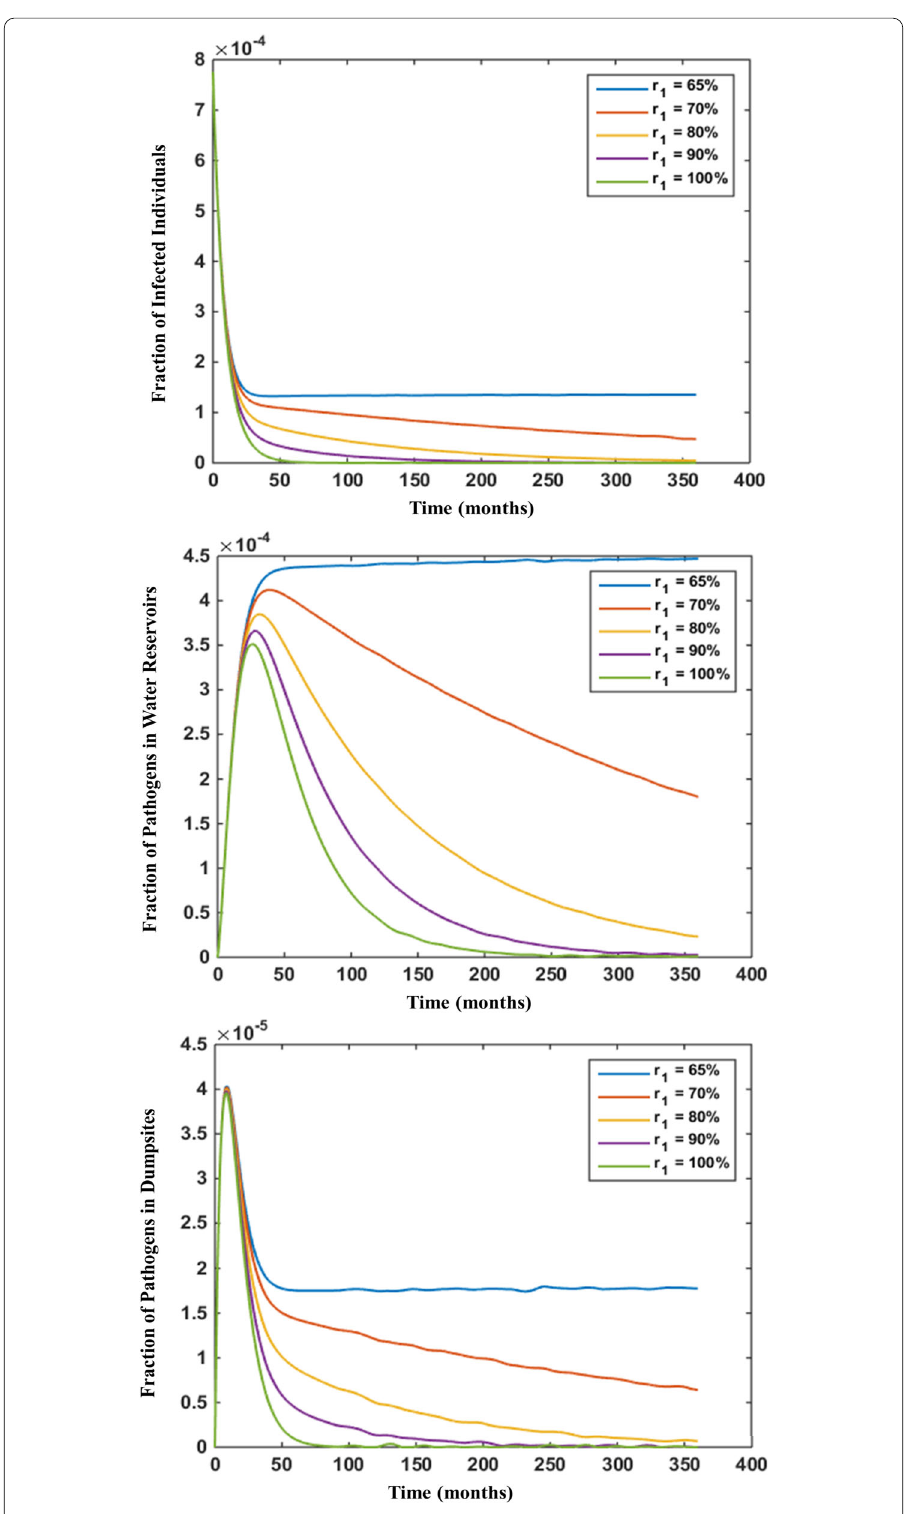
Figure 4 Dynamic behavior of the fraction of infected individuals (top), fraction of pathogens in water reservoirs (middle), and fraction of pathogens in dumpsites (bottom), with r 2 = 35%, r 3 = 10%, and varying r 1 from 65%, 70%, 80%, 90%, and